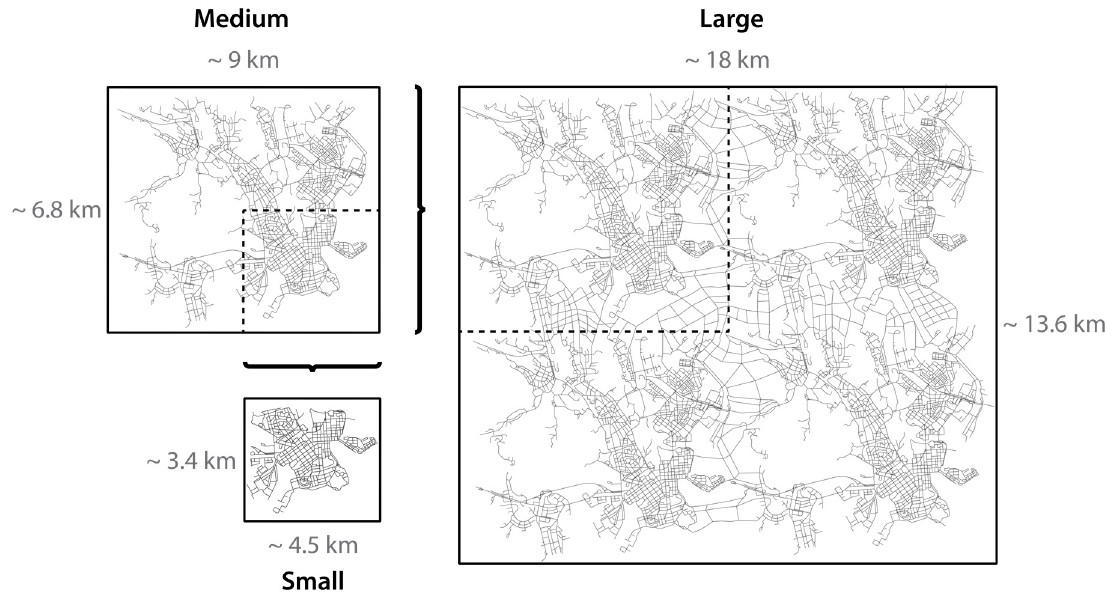
Figure 1. Movement scenarios used for evaluating unfairness in opportunistic network (OppNet) routing protocols (partitioned by a grid, the small, medium and large scenarios consist of 1 region, 4 regions and 16 regions, respectively).